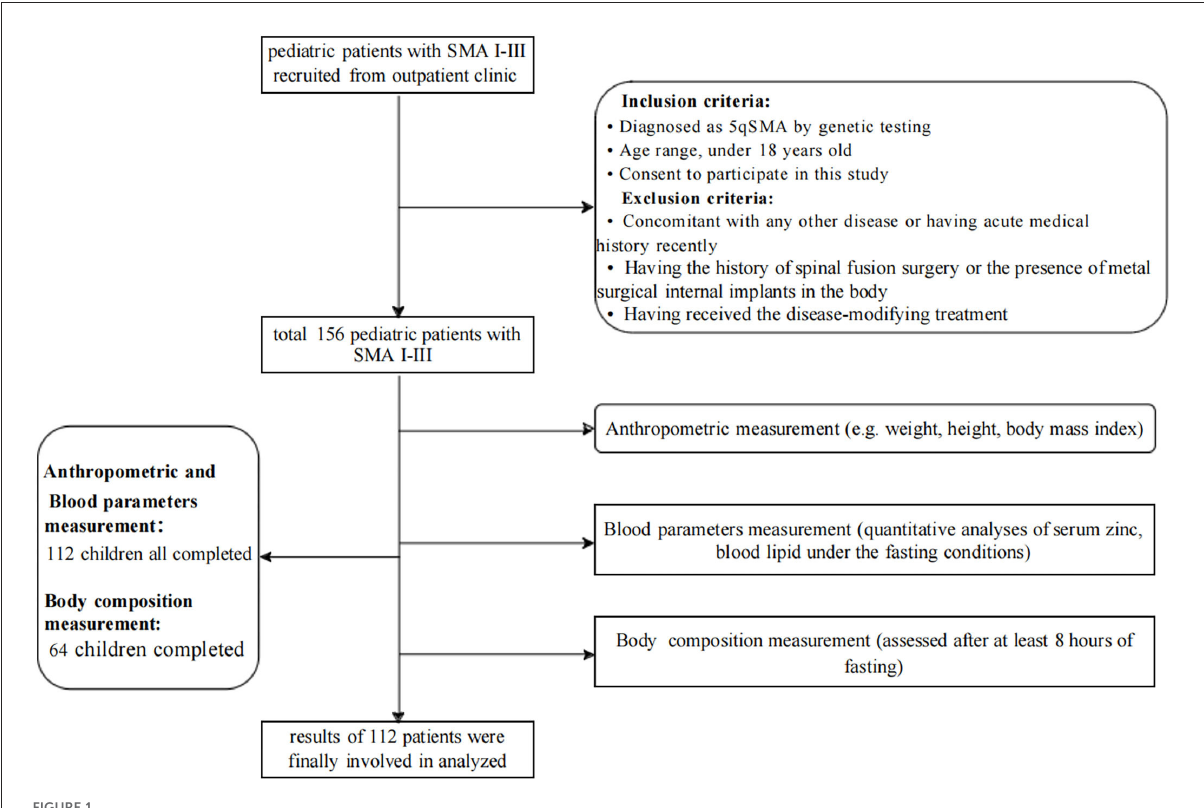
FIGURE1 Flow chart showing patient